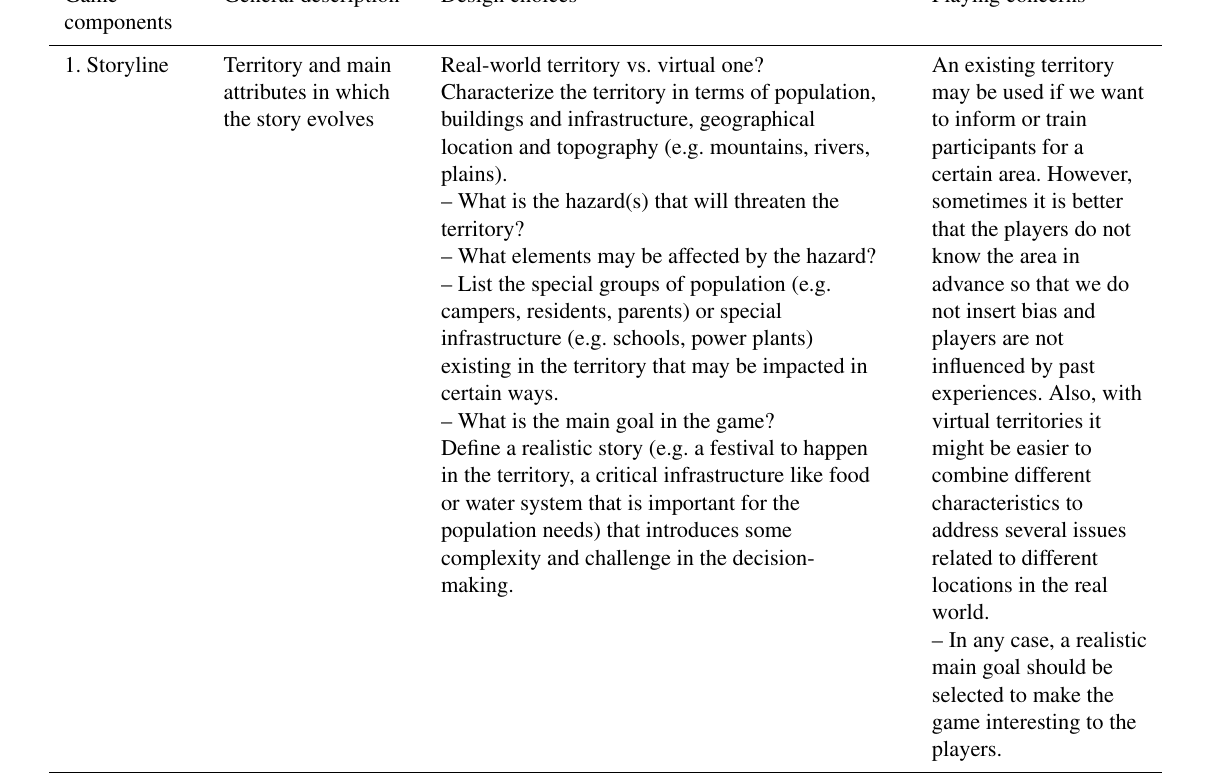
Table 1. Description of the game components and the corresponding design choices to be made when developing